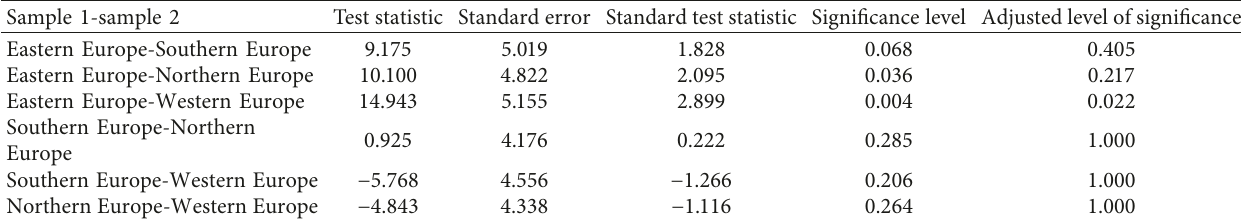
Table 3: Sample average rank of the European regions.